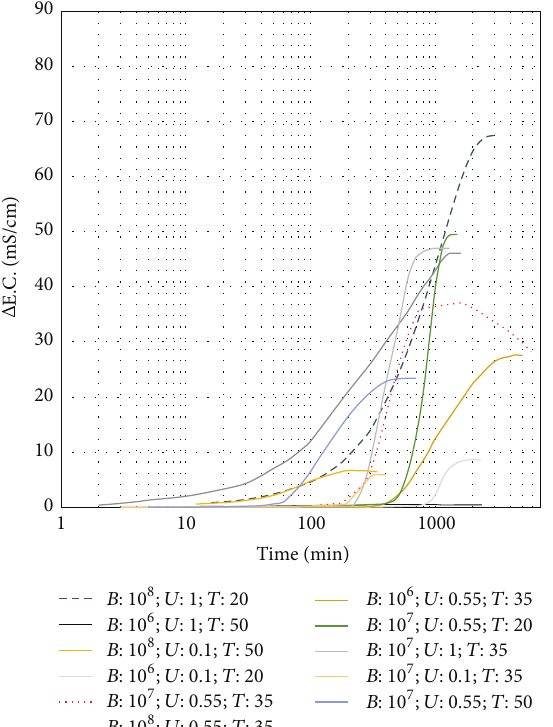
Figure 3: Microbial ureolysis characteristic curve (MUCC) of each experiment.